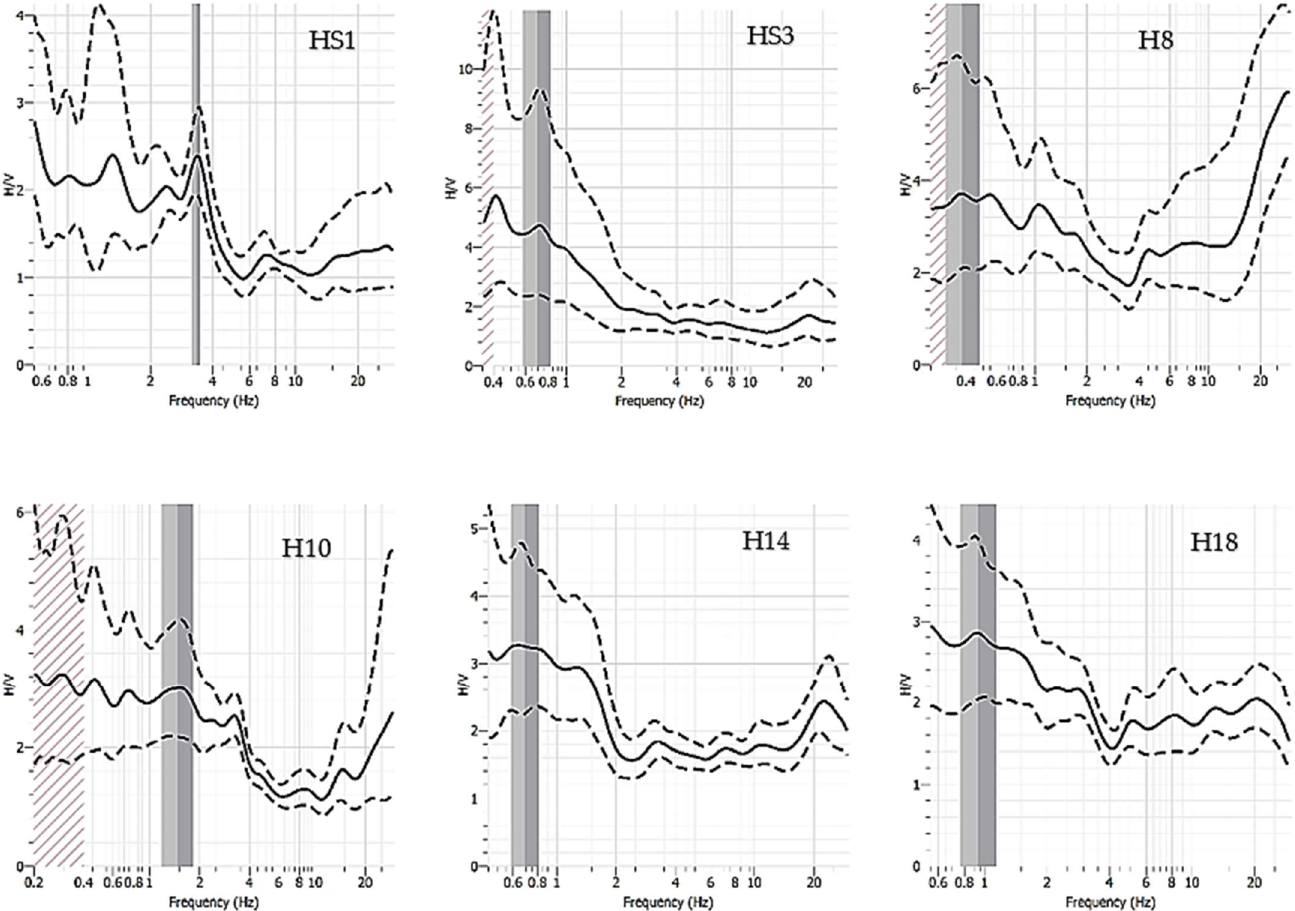
Figure 6. Example of six of the HRSV surveys processing, belonging to the proposed investigation. The two first are measured on control points (the same position as VES surveys). The gray vertical bars indicate the position of the fundamental frequency of each point, and the black dashed line shows the variation on the dispersion curve (continuous).